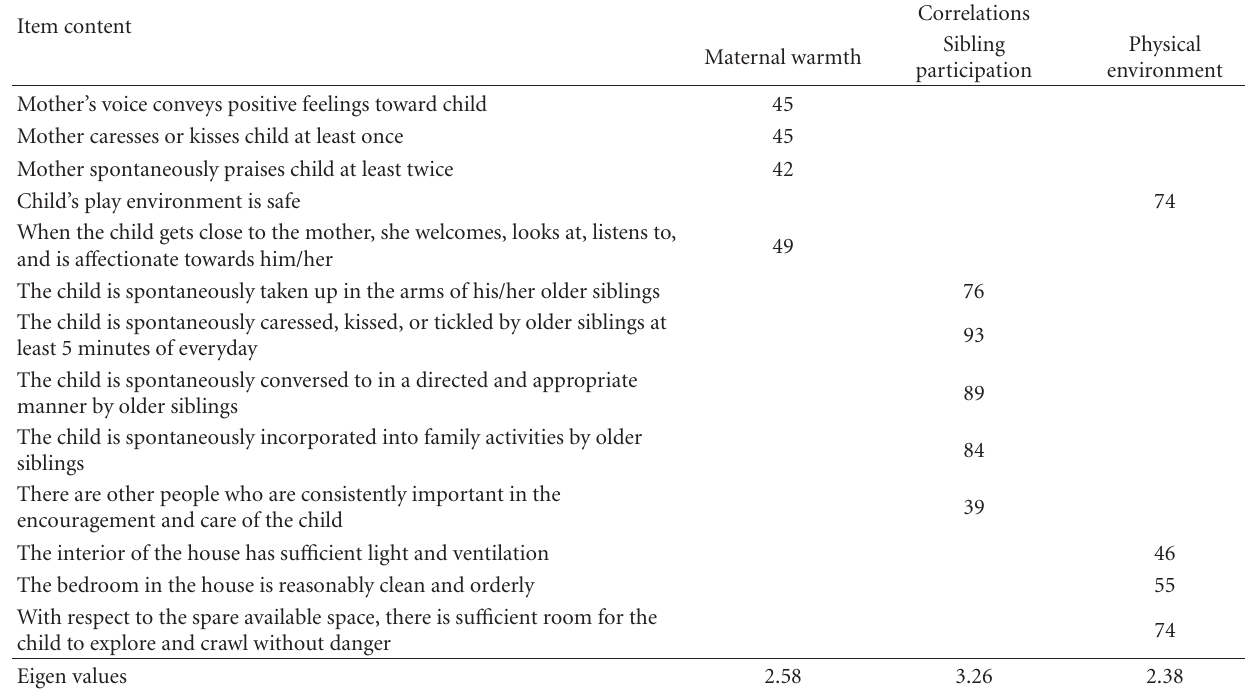
Table 1: Exploratory factor structures and item statistics: maternal warmth, sibling participation, and physical environment a